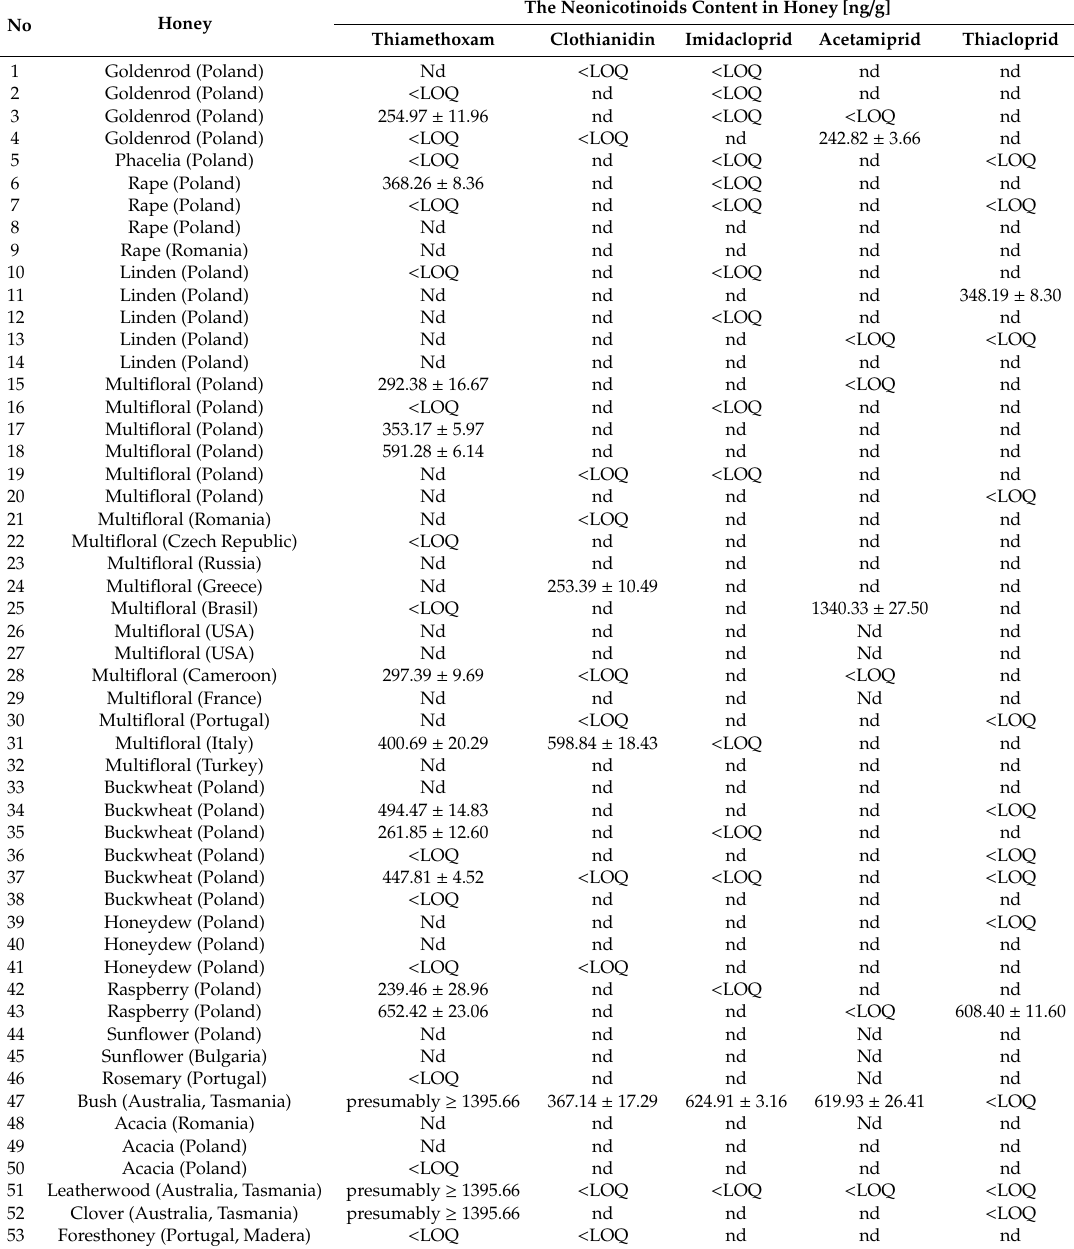
Table 3. Thiamethoxam, clothianidin, imidacloprid, acetamiprid and thiacloprid contents of honeys of di ff erent botanical origin ( n = 3); where: nd—not